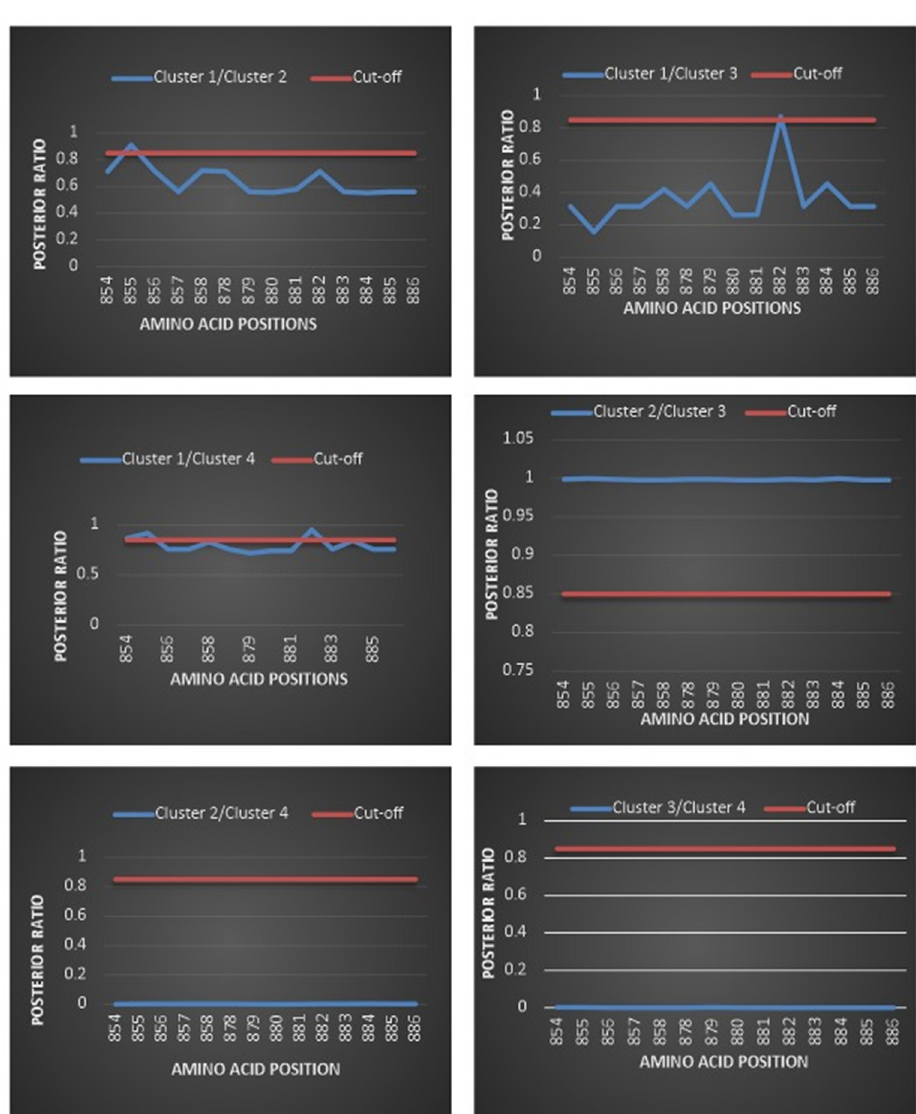
Fig 2. Site-specific profile for predicting critical amino acid residues involved in Type-I functional divergence between different hsp clusters. The red line indicates a cutoff score of 0.85.